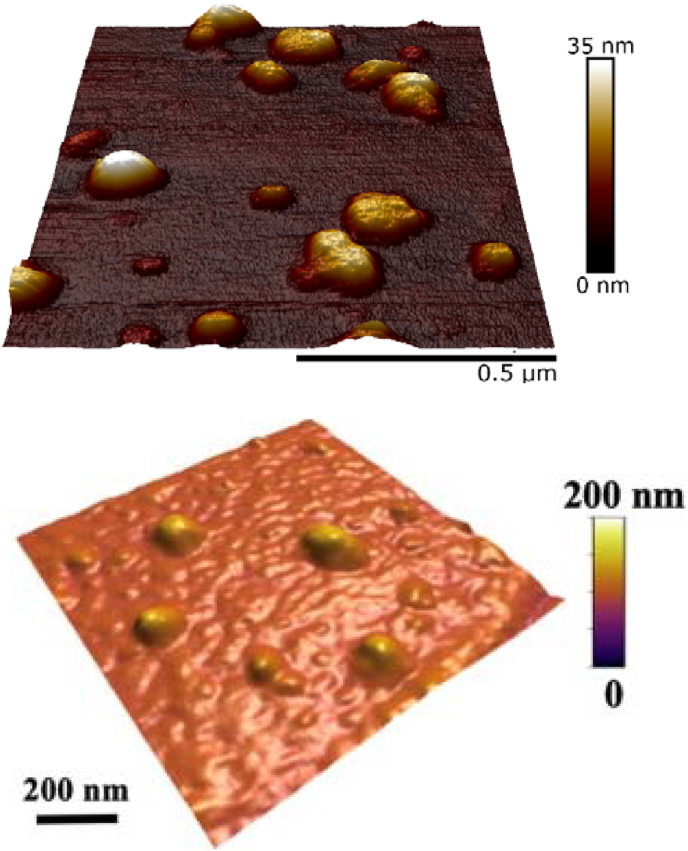
Atomic force microscopy (AFM) images of whey protein microgel particles obtained by a (a) top down (Andablo-Reyes et al., 2019), reproduced with permission from RSC (open access) or (b) bottom approaches (Bahri et al., 2019), reproduced with permission from Elsevier.